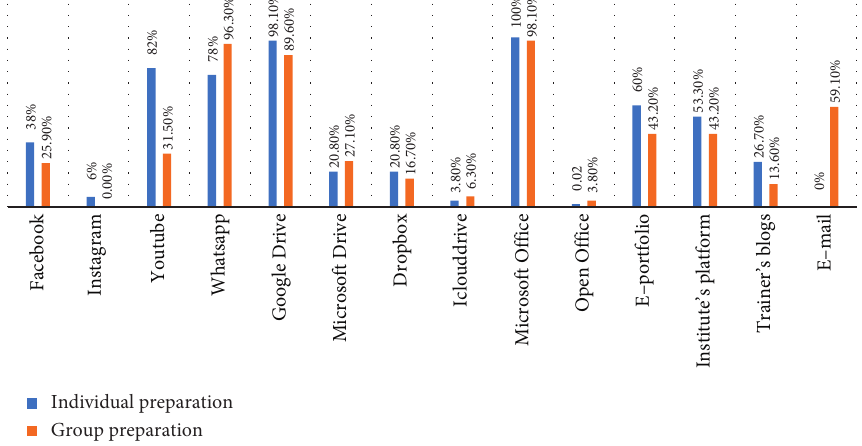
Figure 7: Comparison of the tools dominating the preparation of prospective